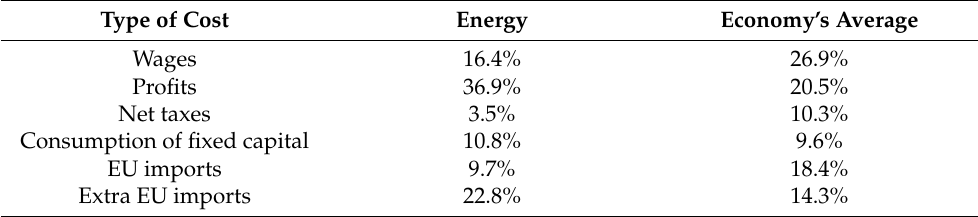
Table 1. The contribution of costs to Energy prices.